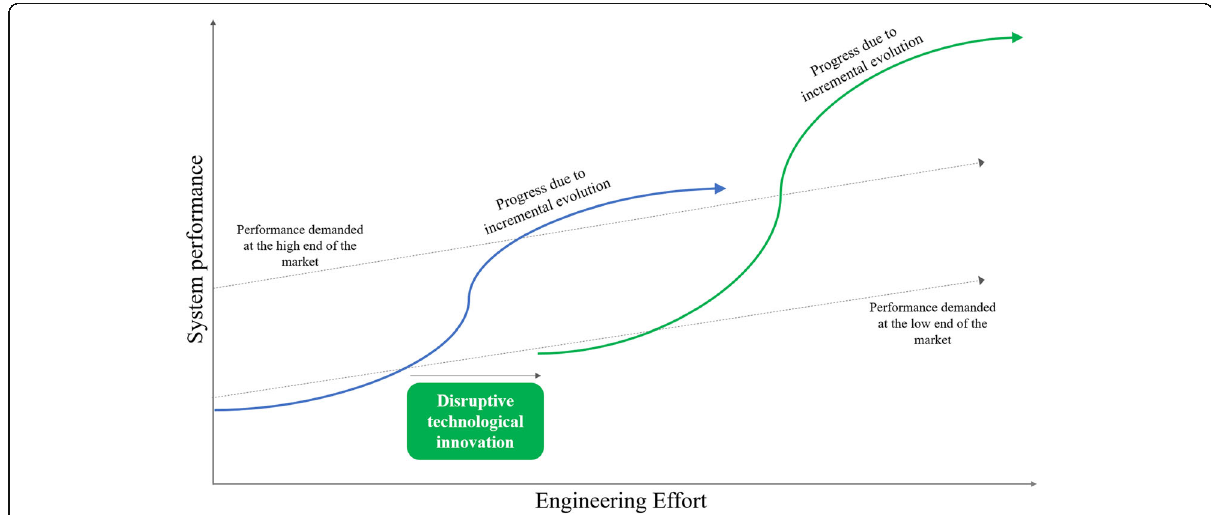
Fig. 1 Disruptive technological innovation (adapted from